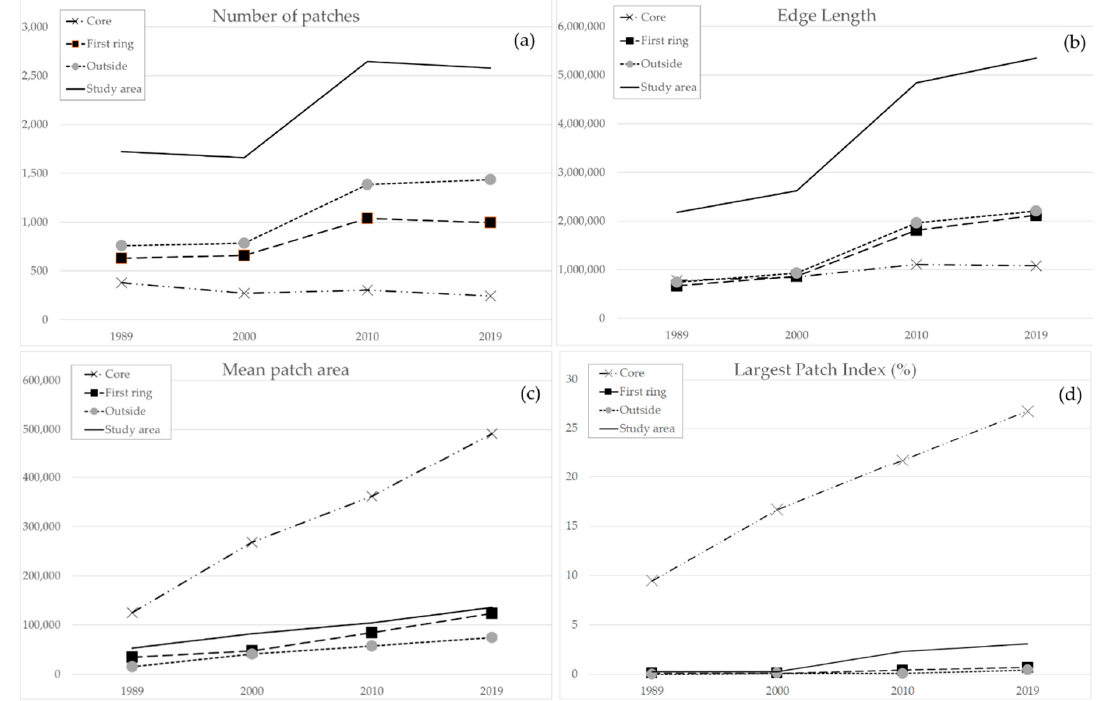
Figure 12. Landscape metric values in the entire study area and by ring in the 1989–2019 period: ( a ) number of patches (NP); ( b ) edge length (EL); ( c ) mean patch area (MPA); ( d ) largest patch index (LPI).